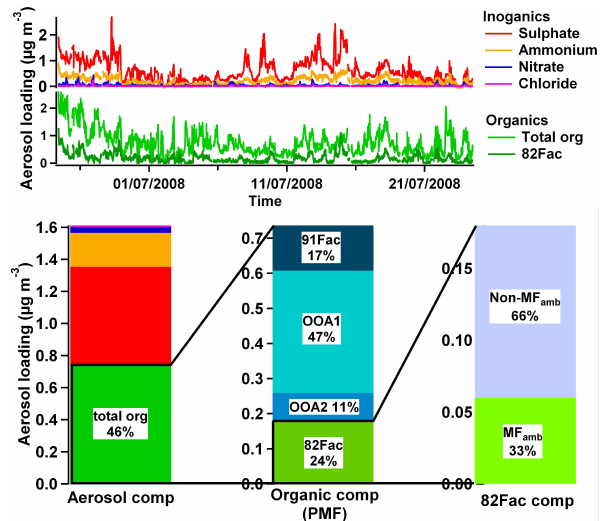
Fig. 1. Top, time series of inorganic and, below that, organic aerosol loading as measured by the AMS. The organic time series also de- tails the m/z 82 containing PMF factor (82Fac). On the bottom are bars showing: the mean aerosol composition (with same colour scheme as in the time series legend); an expansion of the organic component to show the individual PMF factors; and an expansion of the 82Fac to show the contribution from MF which is calculated from the C 5 H 6 O + signal using Eq.